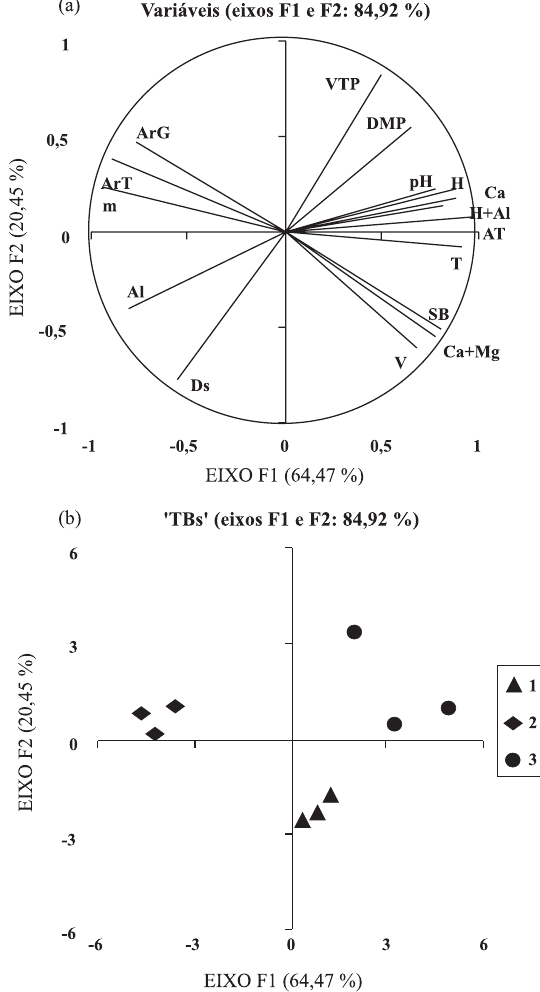
Figura 2. Agrupamento das terras (TB1, TB2 e TB3) em função dos atributos do solo representativos, pela análise de componentes principais, na profundidade de 0,05–0,10 m. (a) atributos do solo e (b) agrupamento das yvy porá